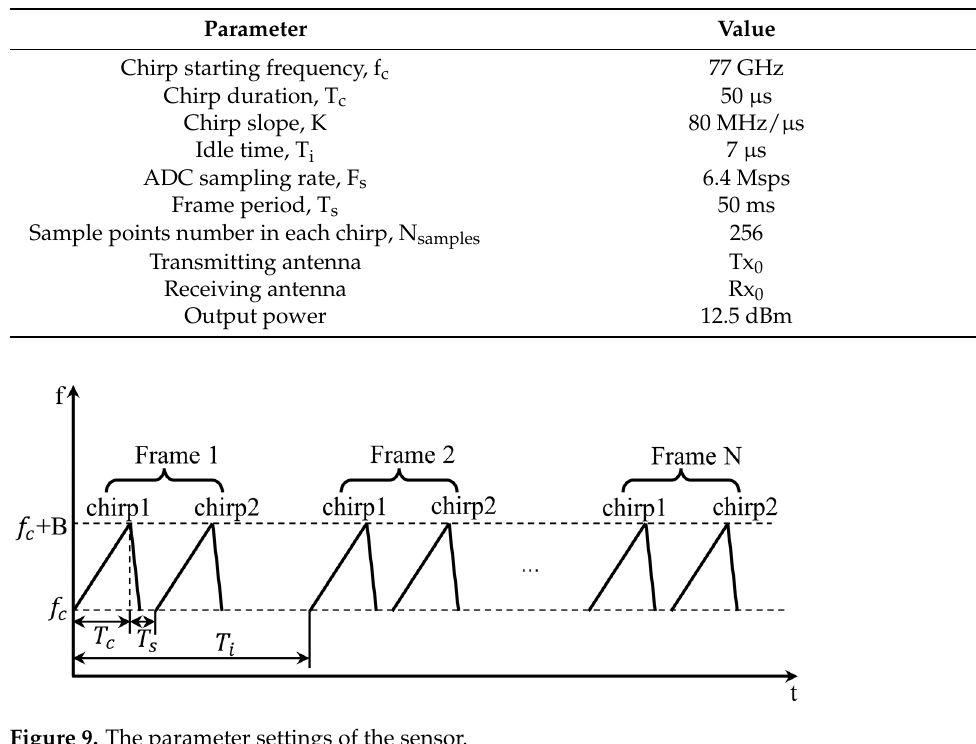
Table 1. FMCW signal parameters for vital signs measurements.